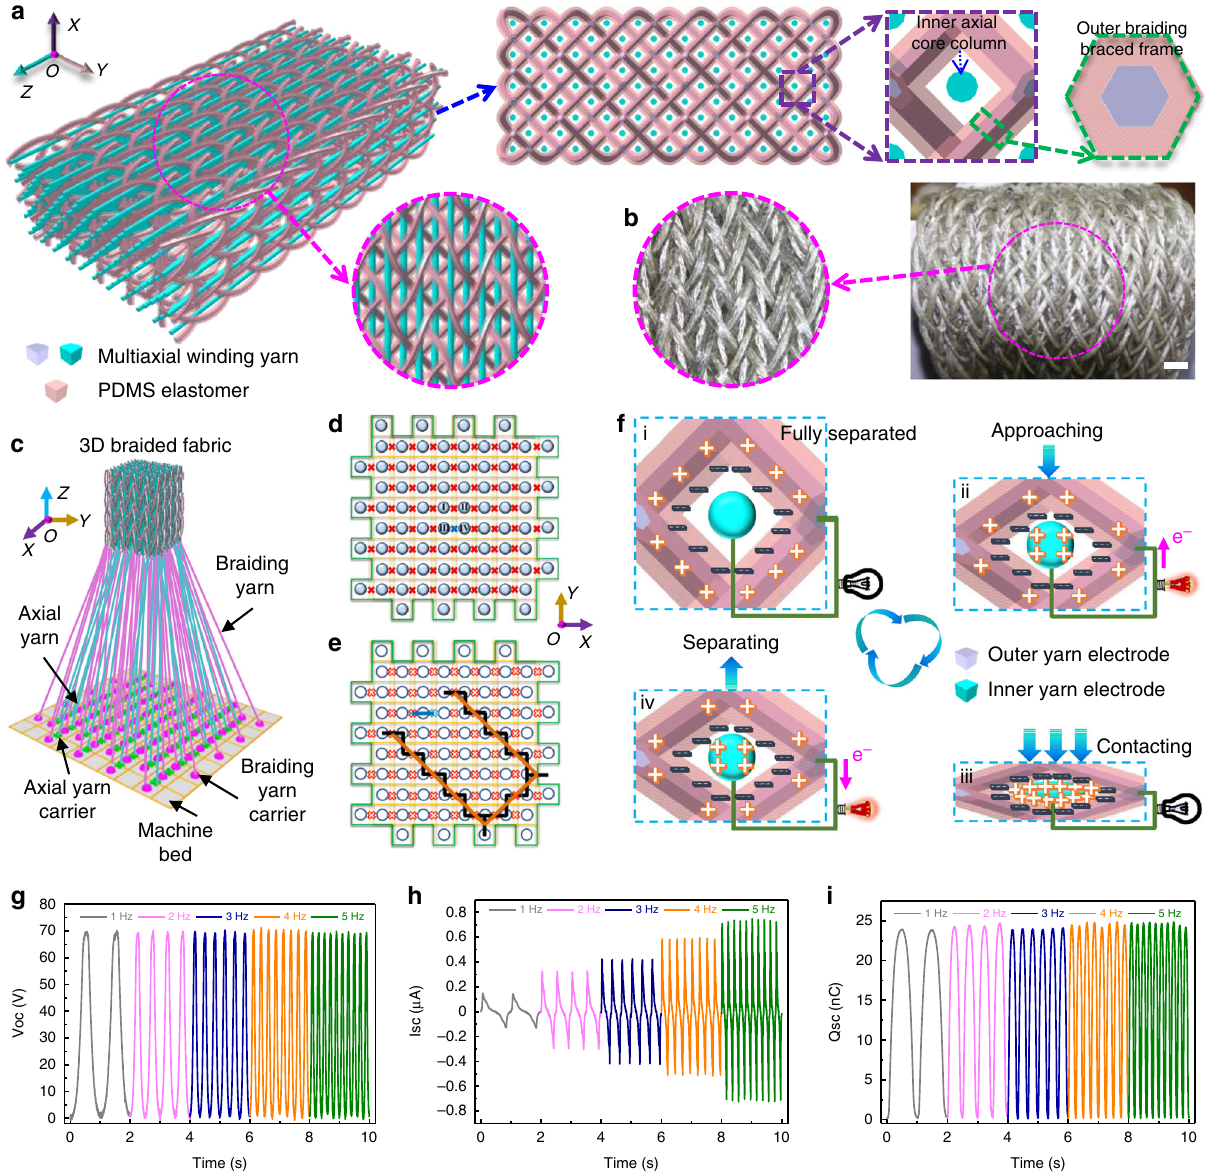
Fig. 2 Structural characteristic, operational principle, and output performance of the 3DB-TENG. a Structural characteristic of the 3DB-TENG, which includes the outer braided braced frame and the inner axial core column. b Photograph image of the 3DB-TENG (scale bar: 1 cm). c Schematic illustration of the 3D four-step rectangular braiding technology. d Distribution of yarn carriers on the machine bed. The braided yarn carriers and the axial yarn carriers are marked with “ O ” and “ X ” symbols, respectively. e Traveled trajectories of one yarn carrier and its suspended yarn. The movement routes of one braided yarn and its yarn carrier are highlighted with an orange line and a black line, respectively. Moreover, the walking paths of one axial yarn and its yarn carrier are indicated with a blue line. f Schematic illustration of the working principle of the 3DB-TENG in a vertical contact and separation mode. g – i Electrical output performance of the 3DB-TENG under different loading frequencies (1 – 5 Hz), including ( g ) V OC , ( h ) I SC , and ( i ) Q SC . Source data are provided as a Source data fi